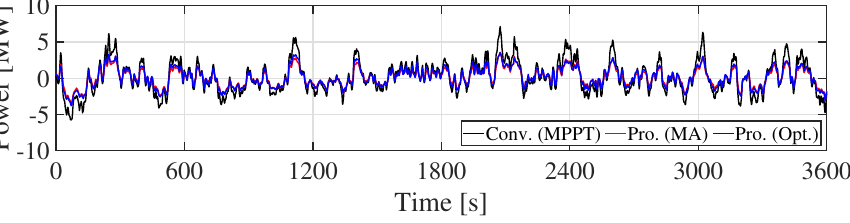
Figure 9. Wind farm (WF) output (Scenario 1).